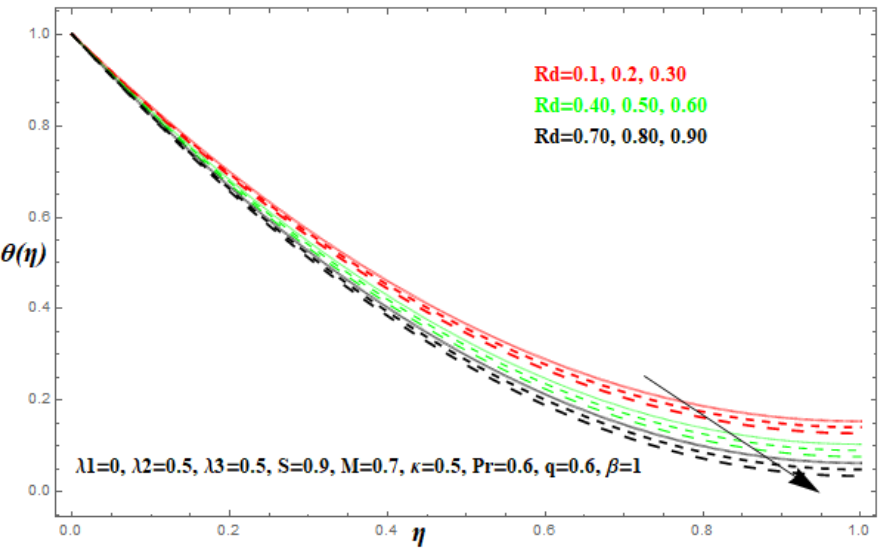
Figure 11. Changes in temperature gradient 𝜃(𝜂) for diverse measures of 𝑅𝑑 .